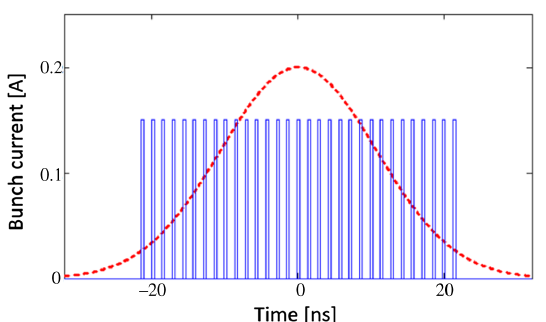
FIG. 2. Longitudinal distribution of the ion bunch (dashed red line) overlapped with the electron macro-bunch (solid blue line) containing thirty